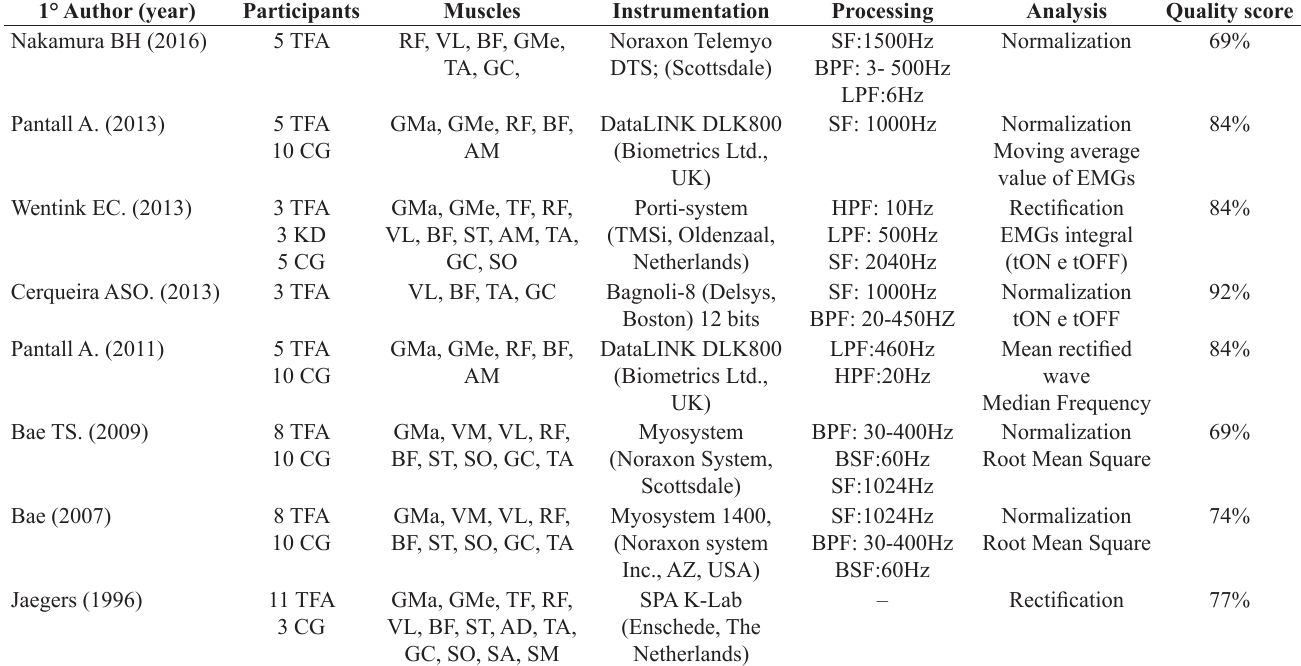
Table 4. General characteristics of selected studies rated by year of